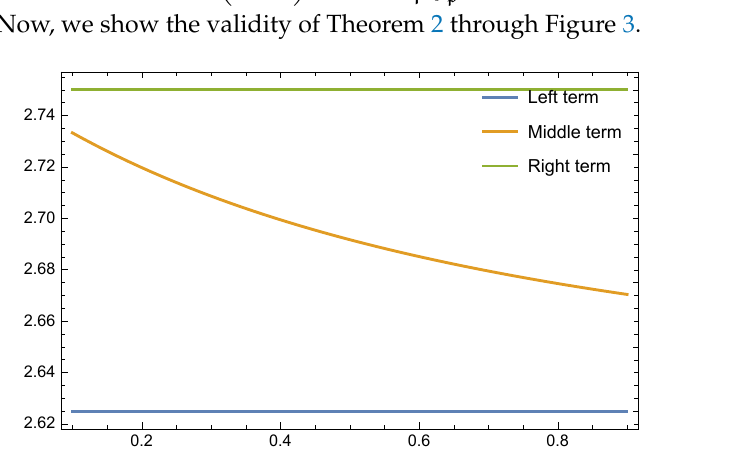
Figure 3. Graphical behaviour of Theorem 2 from the values of Table 2 for 0 < α < 1. Table 2. Numerical validation of Theorem 2 for Example 1. Center Values of Values of α the Left Term the Middle